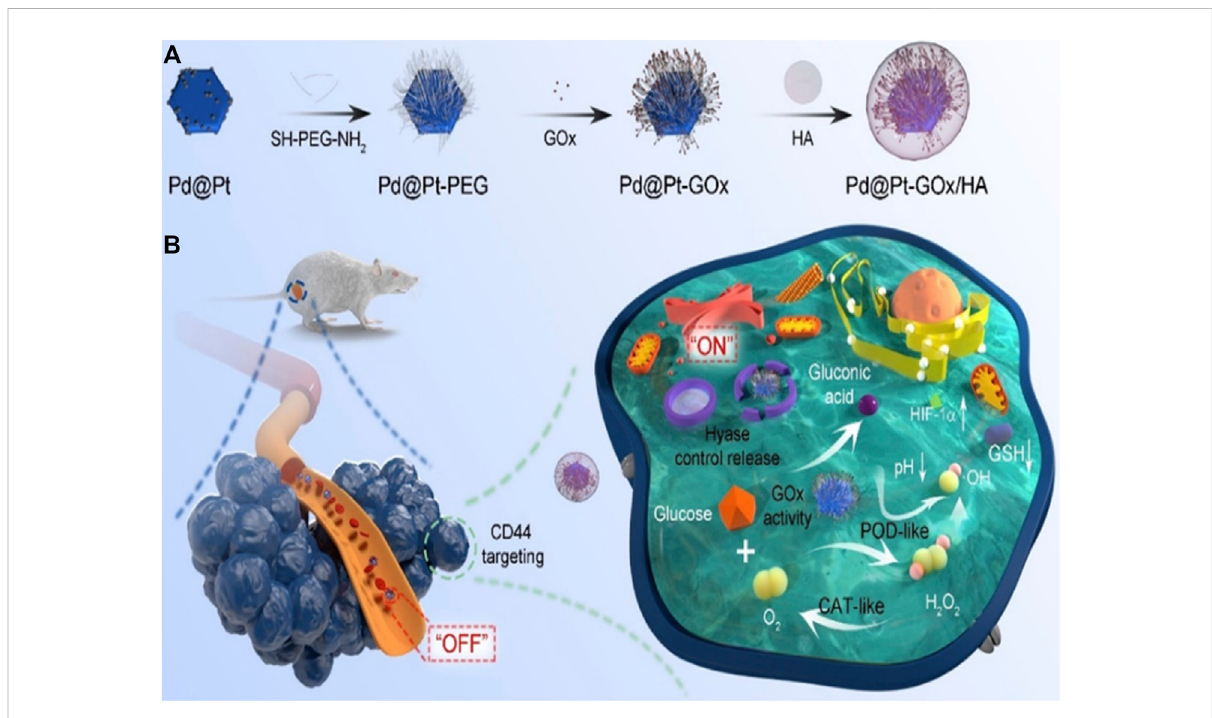
FIGURE 7 Schematic illustration of the synthesis procedure (A) and nanozyme-mediated starving-enhanced chemodynamic cancer therapy (B) of the Pd@Pt-GOx/HA Nanoreactors (Ming et al., 2020). Copyright © 2020 American chemical society.